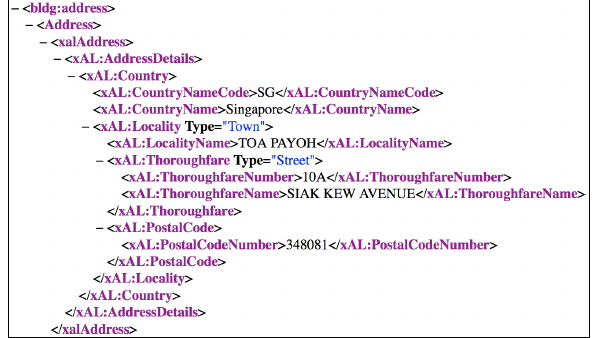
Figure 3. Address details in LOD 2 Building